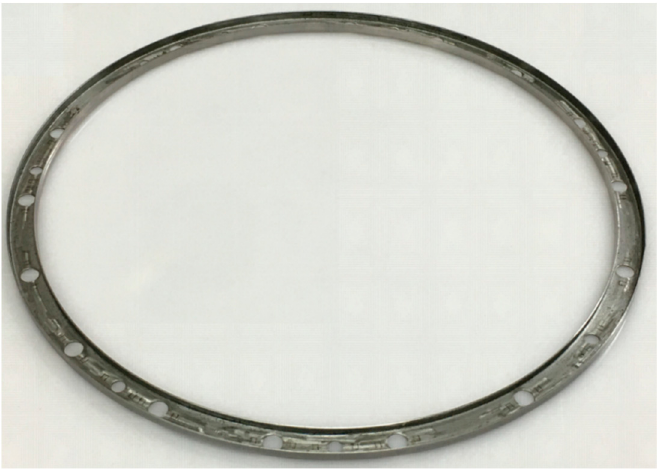
Figure 10. Stamping blank.